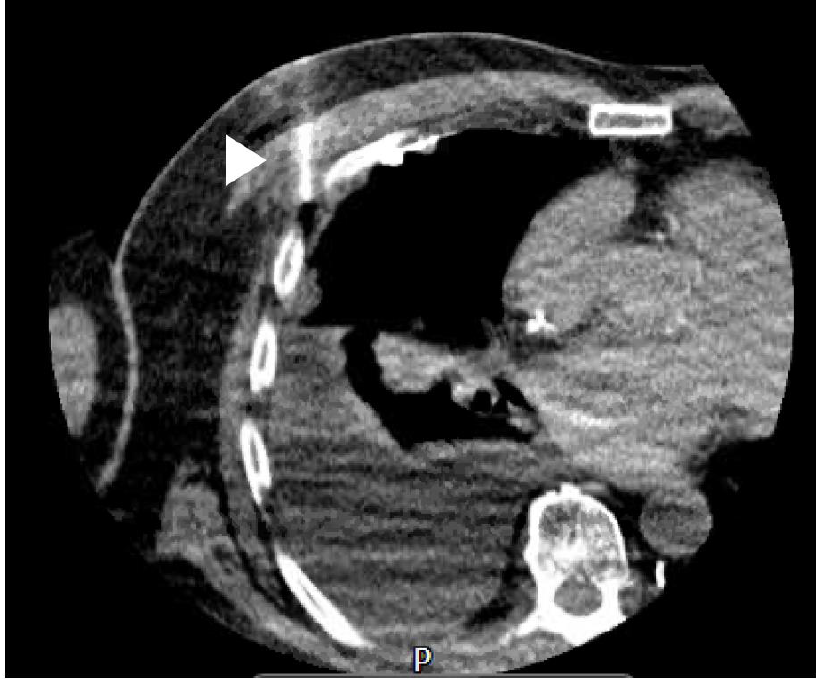
Figure 4. Image of a CT-guided needle biopsy; white arrow = needle.